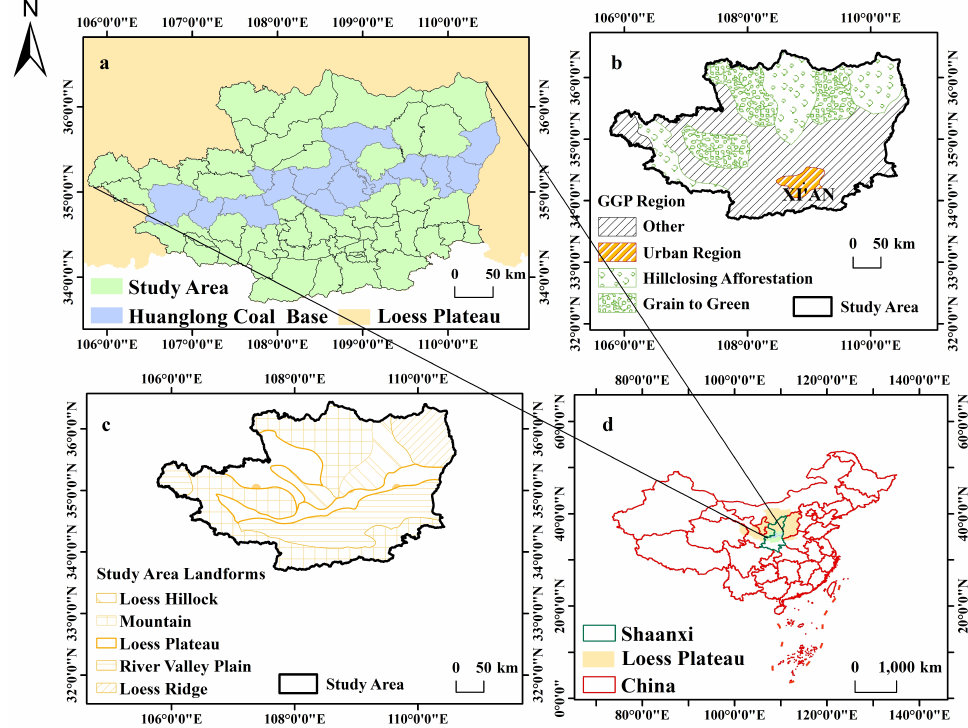
Figure 1. Study area overview: ( a ) Study area; ( b ) distribution of coal mining, GGP, urbanization regions in the study area; ( c ) landform classification of the study area; ( d ) location of the study area in